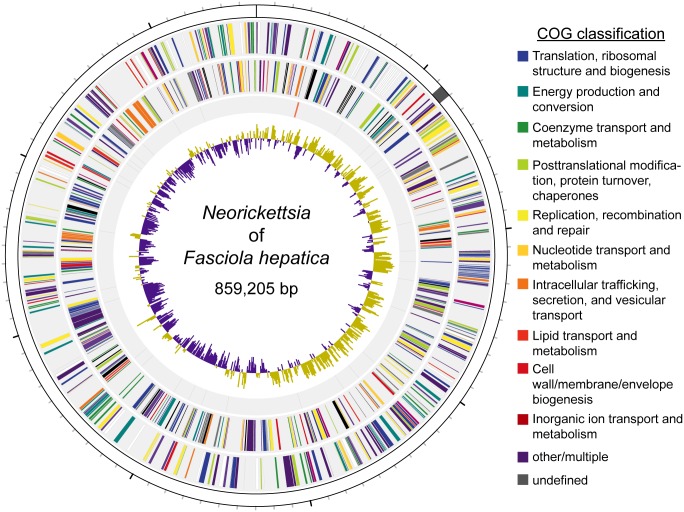
The genome of the Neorickettsia endobacterium of Fasciola hepatica.The first track (from outside to inside) represents the 859,205bp genome of the Neorickettsia endobacterium of Fasciola hepatica (100 kb major ticks, 10 kb minor ticks). The genome shows nearly complete synteny with Neorickettsia risticii and Neorickettsia sennetsu with the exception of an inversion (shaded in grey). The second and third tracks represent the 744 inferred protein coding genes on the plus and minus strands, respectively. Genes are coded based on their NCBI Clusters of Orthologous Groups of proteins database classification. The fourth track represents RNA coding genes, including 3 ribosomal (red), 33 transfer (black), and 1 short, noncoding (blue). The fifth track depicts the G-C skew [(G-C)/(G+C)] calculated over 500bp windows.